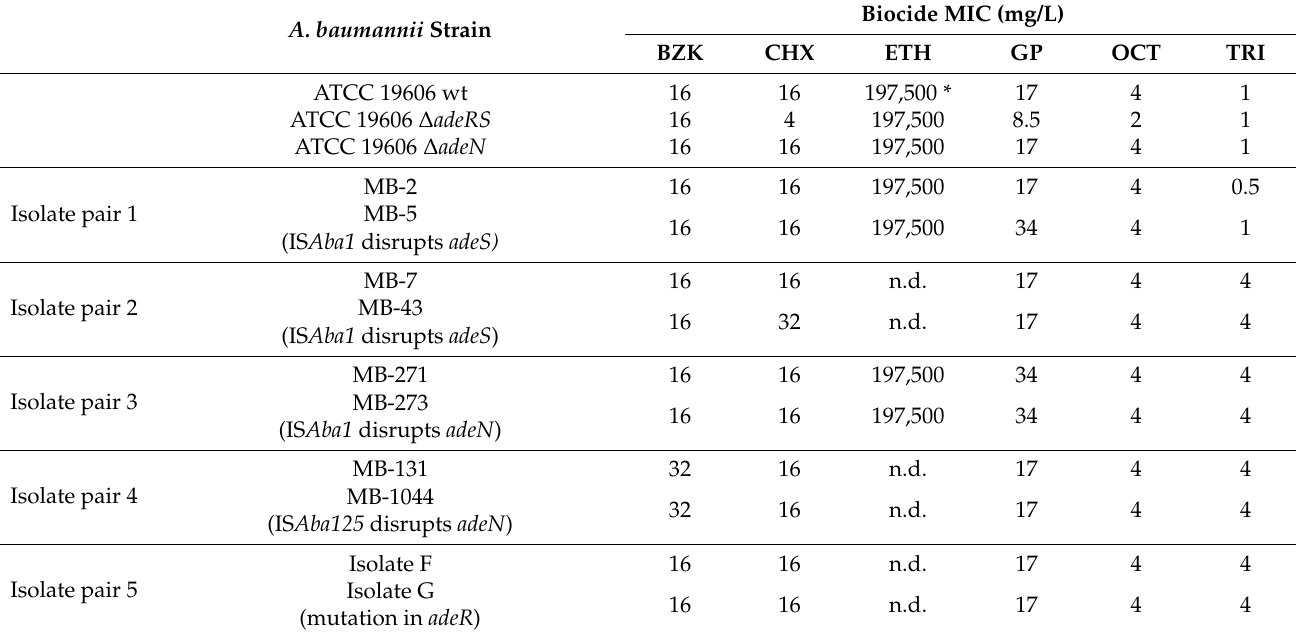
Table 1. Distribution of biocide MICs determined by microbroth